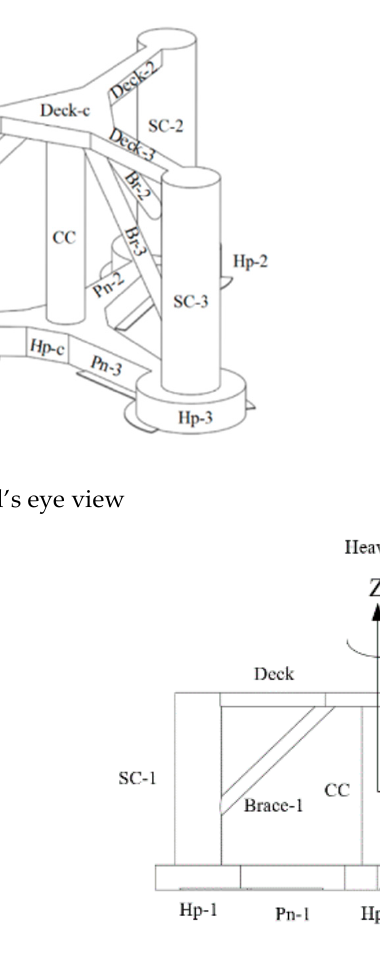
Figure 1. Schematic of the semi-submersible platform and global coordinate system.